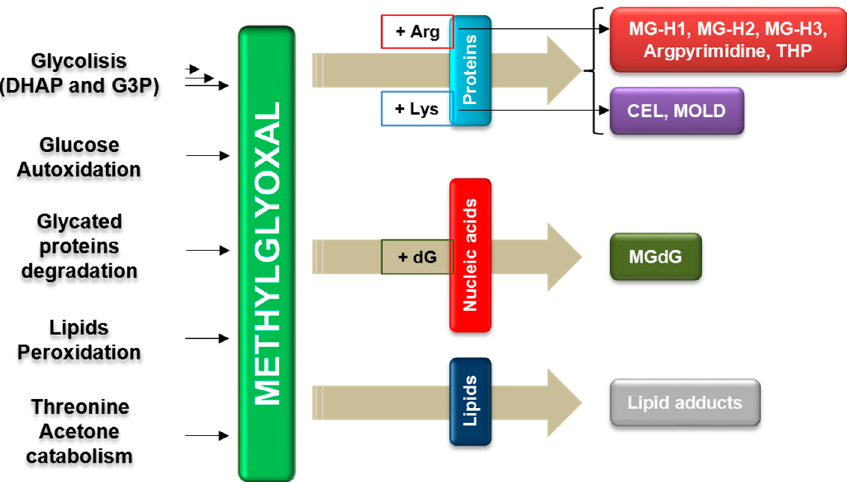
Figure 1. Formation and modification of macromolecules of/by methylglyoxal (MG). In cells, the majority of MG is formed non-enzymatically as a by-product of glycolysis, in particular, from the degradation of dihydroxyacetone phosphate (DHAP) and glyceraldehyde-3-phosphate (G3P) [22,23]. Minor sources of MG are derived from the hydrolysis and dephosphorylation of DHAP and G3P by triosephosphate isomerase [24], from aminoacetone during catabolism of threonine and from hydroxyacetone in the metabolism of acetone [25,26]. MG can also be formed by the decomposition of lipid peroxidation products [27,28], autoxidation of glucose and degradation of glycated proteins [29–31]. MG can modify arginine (Arg) residues of proteins to generate MG-derived hydroimidazolones (MG-H1, MG-H2, MG-H3), argpyrimidine and tetrahydropyrimidine (THP), as well as lysine (Lys) residues to form N ε -(1-carboxyethyl)lysine (CEL) and 1,3-di(N ε -lysino)-4-methyl-imidazolium (MOLD). MG also induces stable modifications of DNA bases (2 ′ -deoxyguanosine, dG) and lipids.